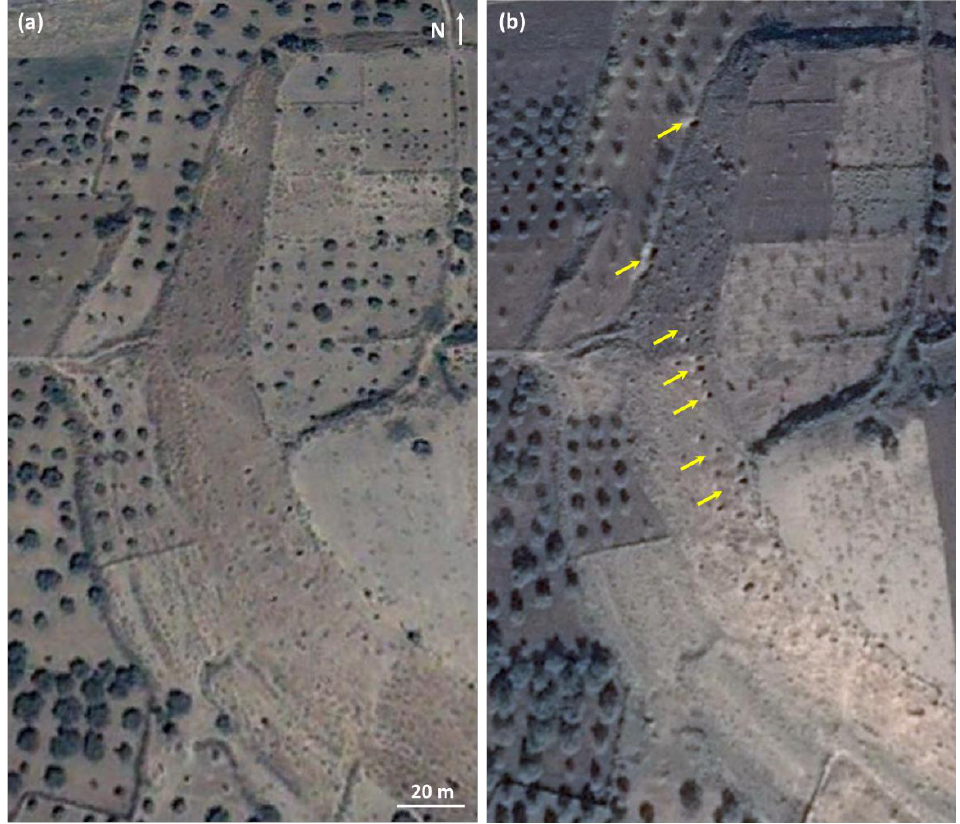
Figure 19. Western slope of Tell Hizareen (Syria), ( a ) before (Google Earth image 06 / 09 / 2012 © 2019 Maxar Technologies), and ( b ) after looting excavations (Google Earth image 03 / 12 / 2015 © 2019 CNES / Airbus). Yellow arrows indicate looting holes, most of which are barely distinguishable from rocks and soil, given the limited visibility and spectral contrast.